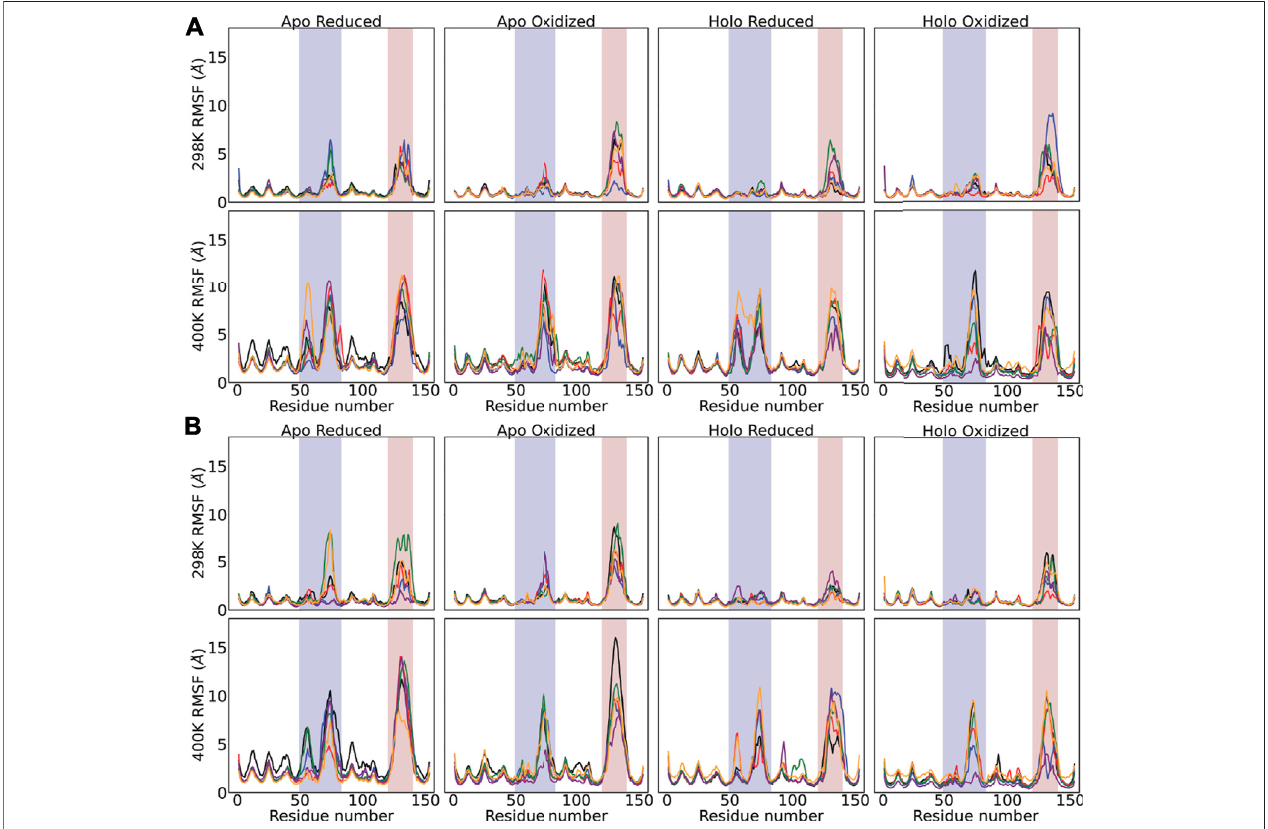
FIGURE 4 | (A) Backbone (C α , C, O and N) displacement and (B) radius of gyration ( R G ) of the SOD1 dimers were monitored for 100 ns. For both sub-plots, top- panel shows the 298 K and bottom-panel shows 400 K simulations. The same legend applies for all subplots: Wild-type-black, H63A-red, H63R-blue, K136A-green, G37R-purple,